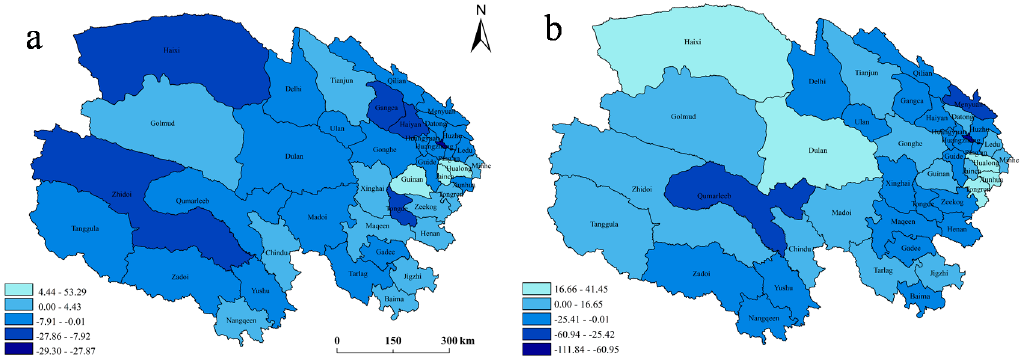
Figure 4. Change of ecological service value per unit area of each town (city) in ( a ) 1988–2000 and ( b ) 2000–2008 (yuan/hm 2 ).